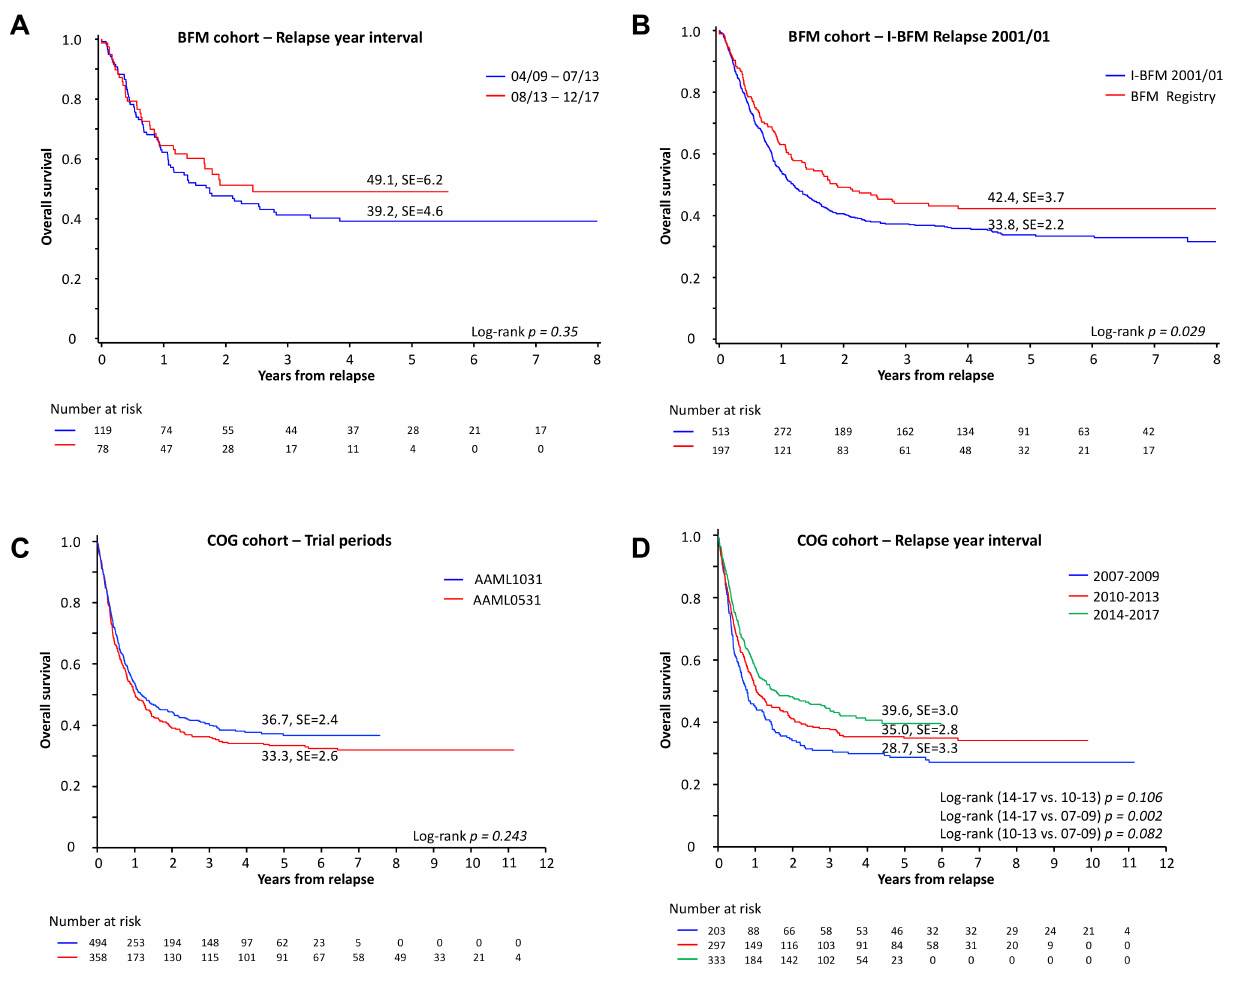
Figure 1. Overall survival at first relapse. ( A ) Five-year overall survival in patients with pediatric AML with diagnosed first relapse from 04/2009 until 07/2013 vs. 08/2013—12/2017. ( B ) Five-year overall survival in patients with pediatric AML with first relapse enrolled in the BFM registry compared to patients with first relapse enrolled in the previous I-BFM Relapse 2001/01 trial. ( C ) Five-year overall survival following relapse of patients enrolled on COG AAML0531 and COG AAML1031. ( D ) Five-year overall survival for first relapse patients in the COG cohort by year. Group 2018 until 2019 is